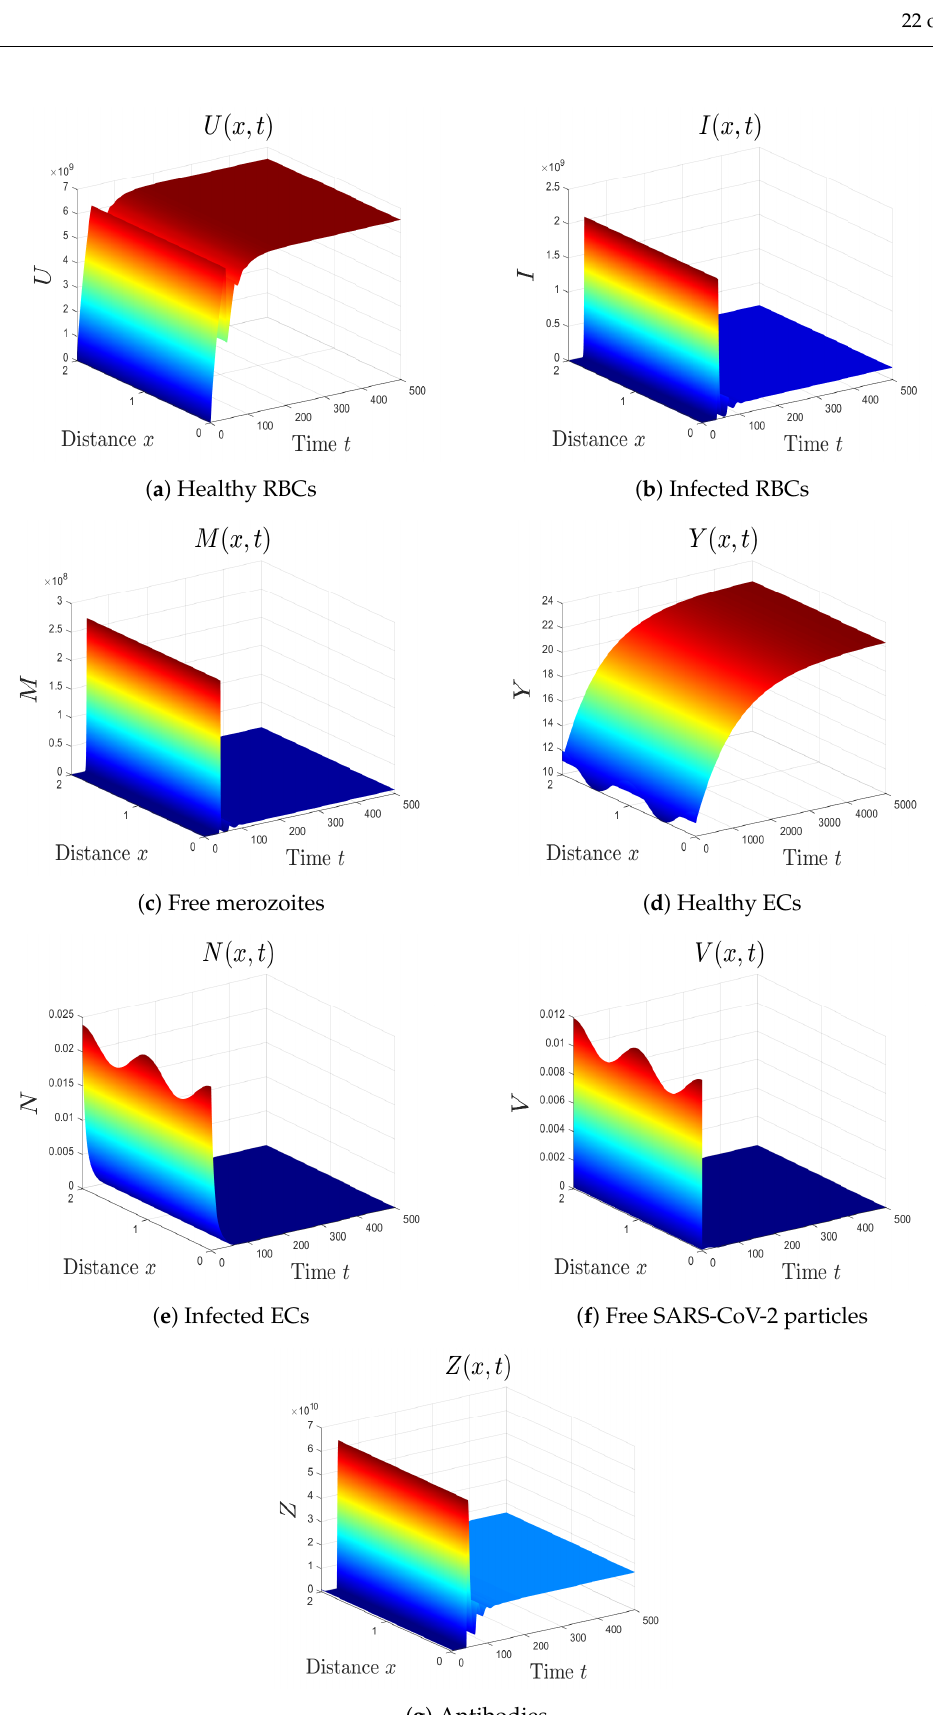
Figure 3. Simulation of system (1) for ( β m , β v , p 1 , p 2 , d 7 ) = ( 2 × 10 − 9 ,0.1,3 × 10 − 8 ,0.96,0.2 ) . The equilibrium E 2 = ( 6.522 × 10 9 ,1.739 × 10 8 ,6.667 × 10 6 ,22.41,0,0,1.607 × 10 10 ) is